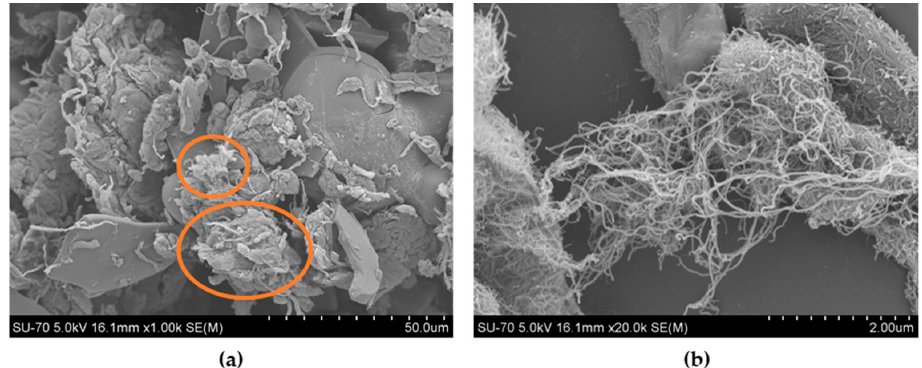
Figure 5. SEM image of a mixture of LS with 1% w / w MWCNTs ( a ) with an expanded image of MWCNT bundles bound to lignin particles ( b ). Examples of large MWCNT agglomerates are depicted by circles.